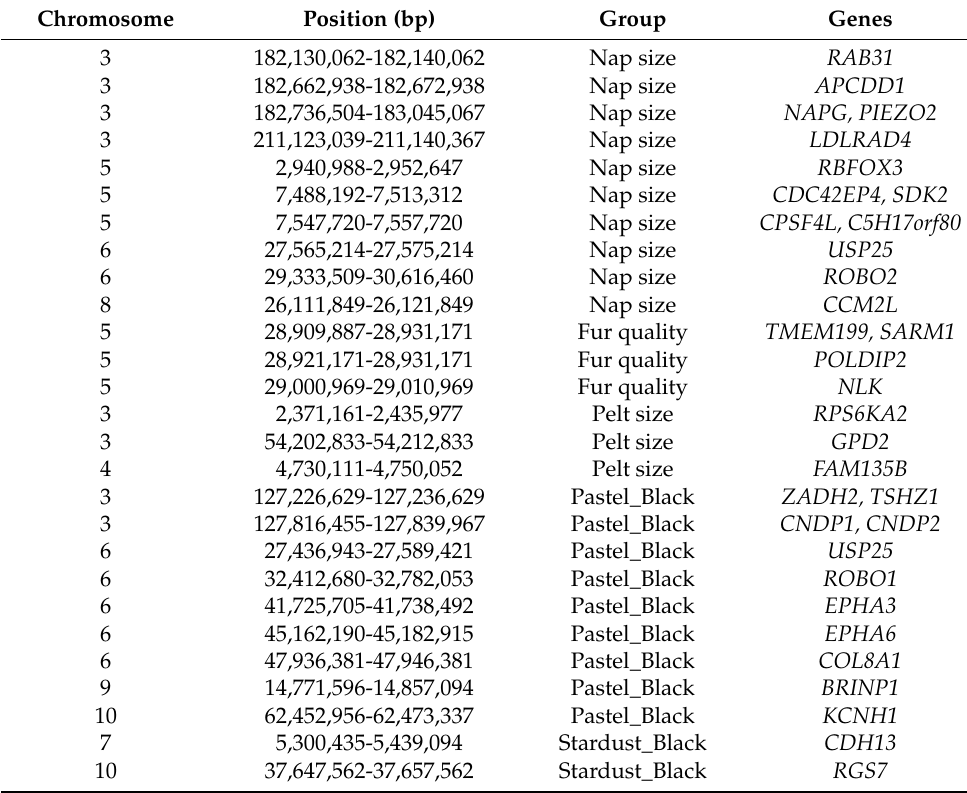
Table 2. Overlapping candidate regions and annotated genes identified by three methods ( θπ ratios, Fst, and XP-EHH) for fur quality and coat color in American mink. Chromosome Position (bp) Group